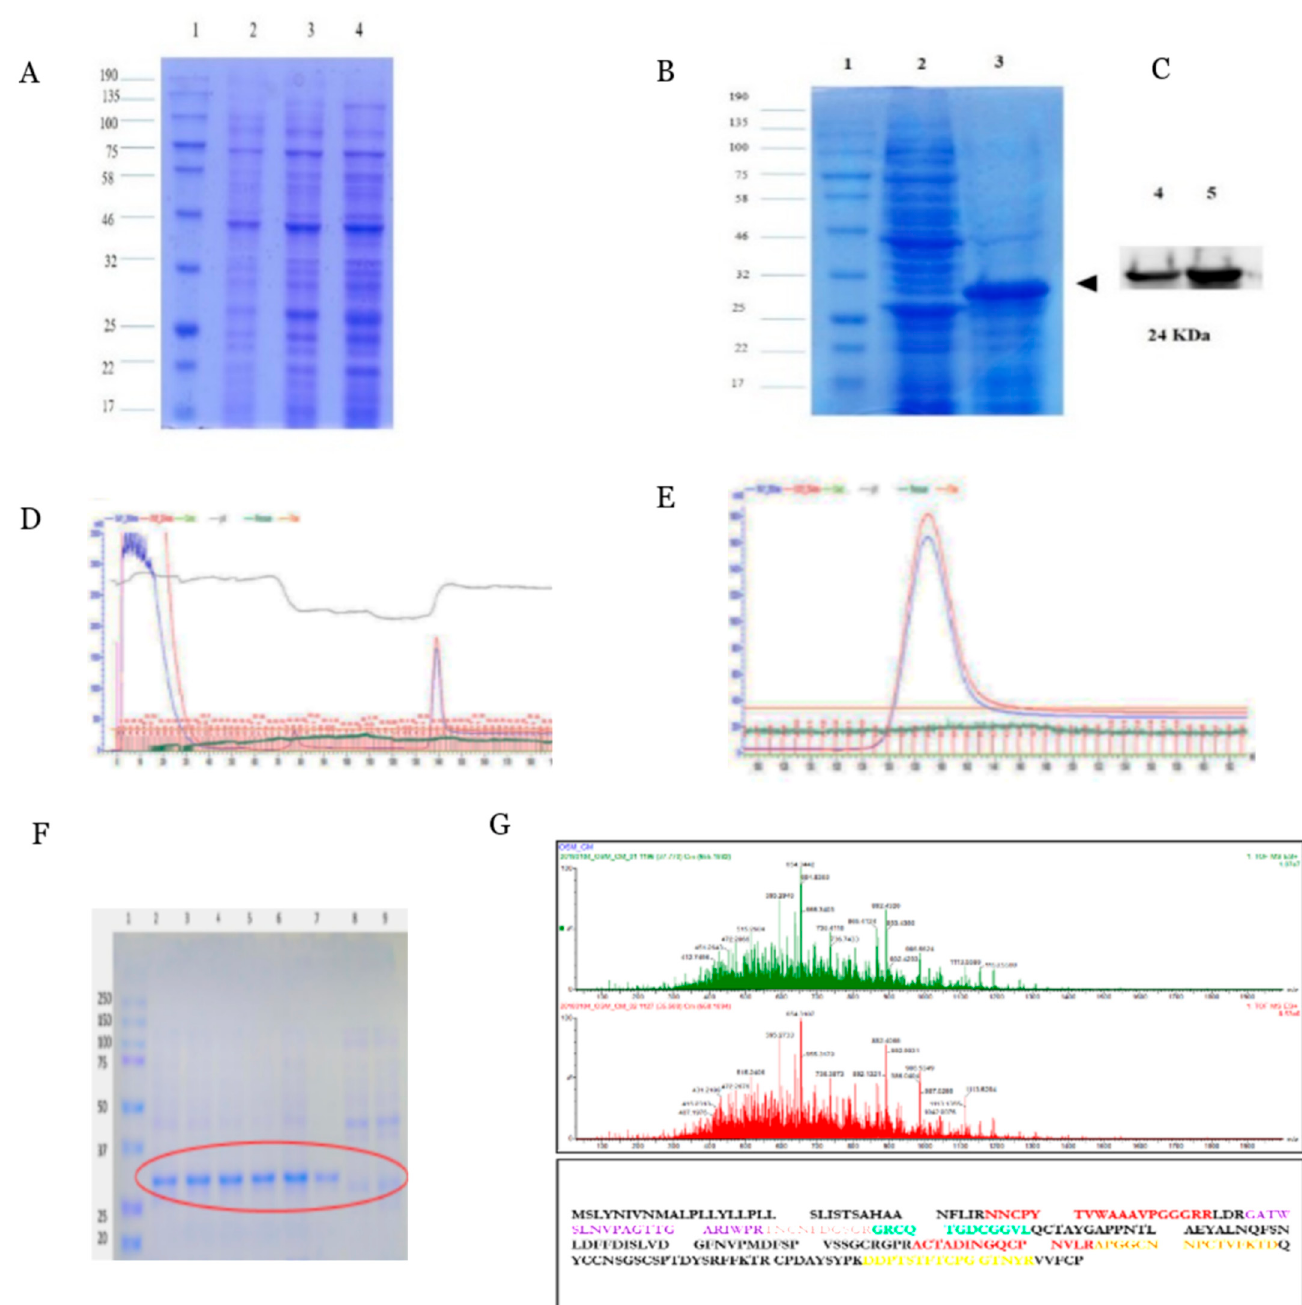
Figure 1. Purification of His 6 tagged recombinant Piper colubrinum Osmotin in E. coli : ( A ) SDS-PAGE analysis of the expression of 6xHis tagged PcOSM in E. coli cultures expressed at 37 ° C Lane 1. Molecular mass marker (NEB), (2–4)-Total protein from non-induced, induced by 1mM IPTG for 6h and 8 h. ( B ) SDS PAGE of crude protein and partially purified recombinant PcOSM protein, ( C ) Western blot analysis of His tagged PcOSM, probed with Anti-polyhistidine antibody, ( D ) and ( E ) AKTA chromatogram obtained from purification optimization. ( F ) SDS-PAGE analysis of purified elute fractions obtained from purification optimization -Lane 1: Molecular marker (NEB), lane 2-9-elute, ( G ) LC-MS/MS analysis of osmotin showing mass spectrum of osmotin and the unique peptides identified were highlighted in different colours.